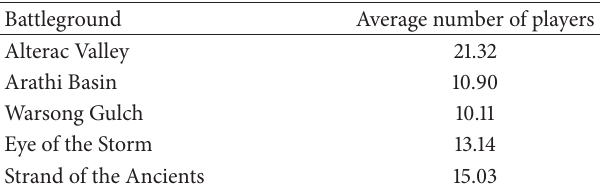
Table 1: Estimated Average Number of Players per Battleground.